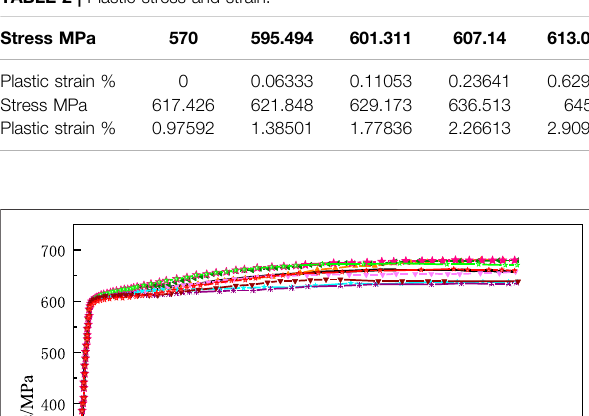
TABLE 2 | Plastic stress and strain.